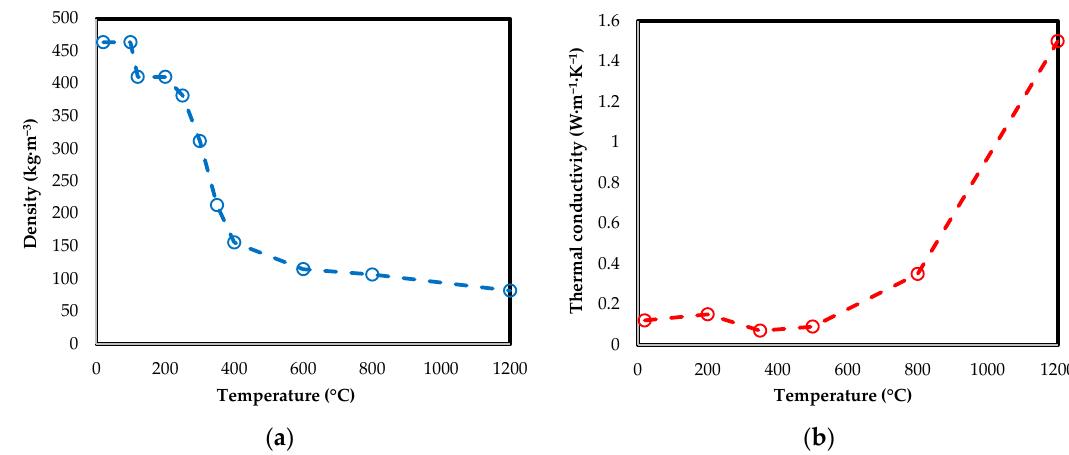
Figure 4. Properties of Norway spruce: ( a ) density; ( b ) thermal conductivity.